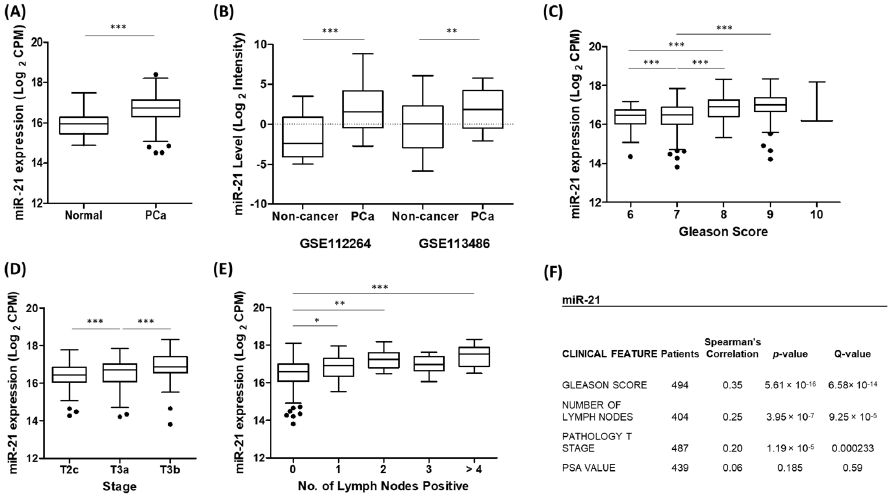
Figure 1. Up-regulation of miR-21 is associated with prostate cancer. ( A ) UCSC Xena analysis of TCGA-PRAD samples shows miR-21 expression is significantly increased in prostate tumour tissue ( n = 494) compared to that of normal prostate tissue ( n = 52). (Welch’s t -test *** p < 0.001). ( B ) miR-21 is significantly elevated in the serum of prostate cancer patients compared to that of healthy, non-cancer control patients. Data are from GEO datasets GSE112264 ( n , Non-cancer = 41, PCa = 809) and GSE113486 ( n , Non-cancer = 100, PCa = 40). (One-way ANOVA with multiple comparison tests, ** p < 0.01, *** p < 0.001.) UCSC Xena analysis of TCGA-PRAD samples shows expression of miR-21 is significantly associated with ( C ) Gleason grade ( D ) pathological T stage and ( E ) number of positive lymph nodes. (One-way ANOVA with multiple comparison tests, * p < 0.05, ** p < 0.01, *** p < 0.001). ( F ) Firebrowse analyses of TCGA-PRAD data ( n > 400) confirm miR-21 expression had significant positive correlation with Gleason score, number of positive lymph nodes and pathological T stage. ( p - and Q -values were generated by Spearman’s correlation with multiple hypothesis correction.) All boxplots show mean and Tukey whiskers.